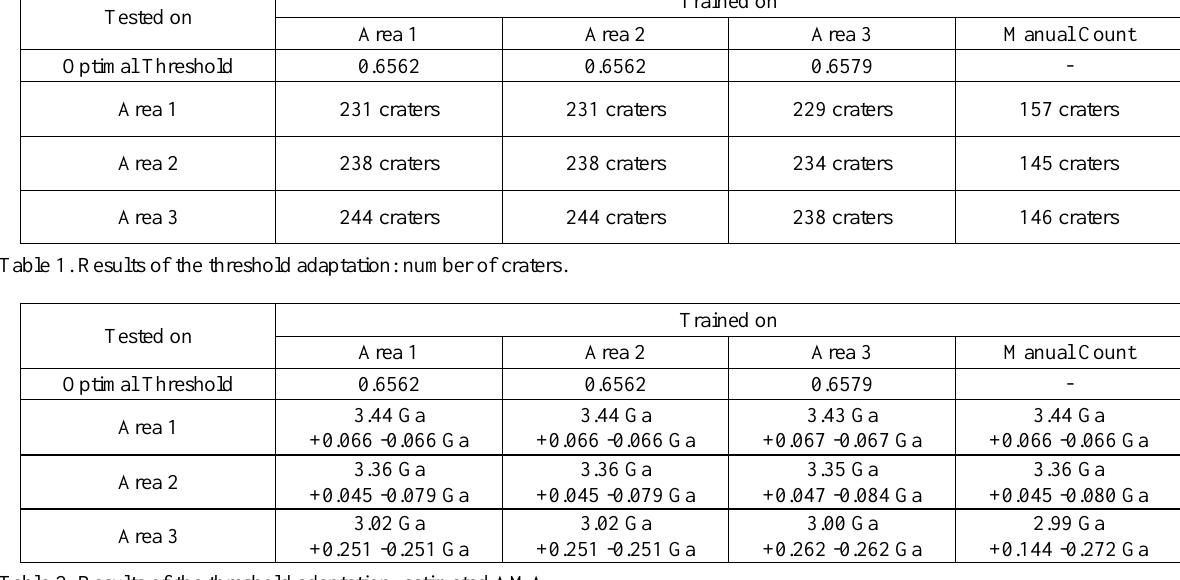
Table 2. Results of the threshold adaptation: estimated